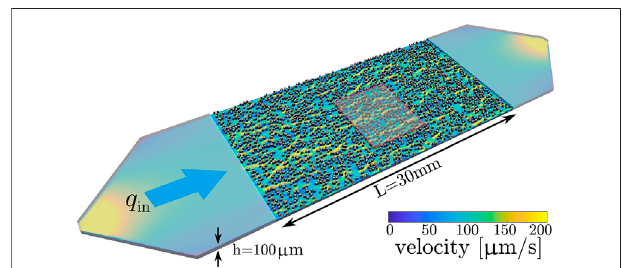
FIGURE 1 | Sketch of the experimental setup showing the whole pore geometry together with the simulated fl ow fi eld in the mid plane for the non- Newtoniancaseat qin5µL/min.TheporousregionisL30mmlong,B15mm wideandhasaheightofh100µm.Theradiusofthecircularpillarsisalso 100 mµ. The gray shaded region marks the part of the porous device where the experimental fl ow velocity measurement has been